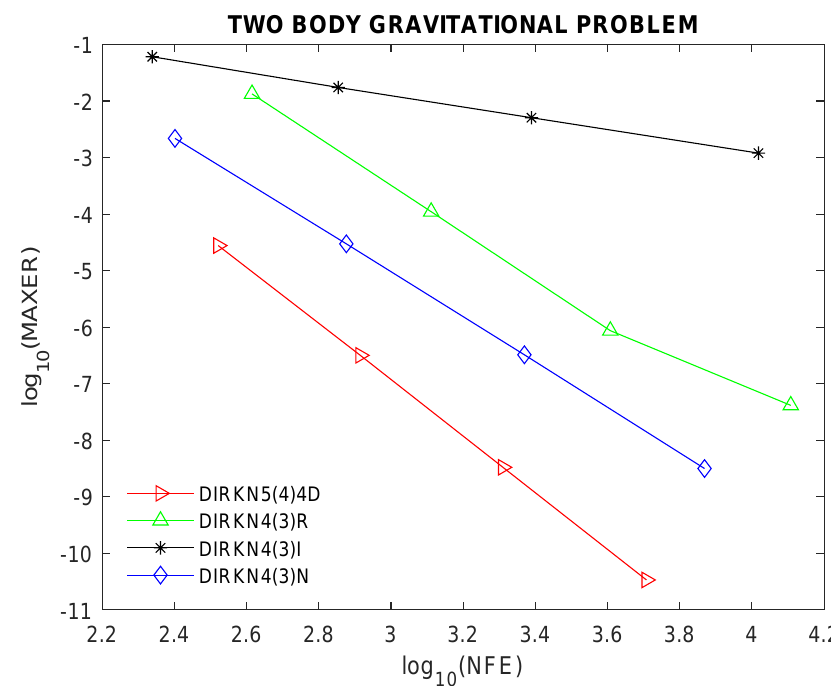
Figure 4. Efficiency curves for Example 4.